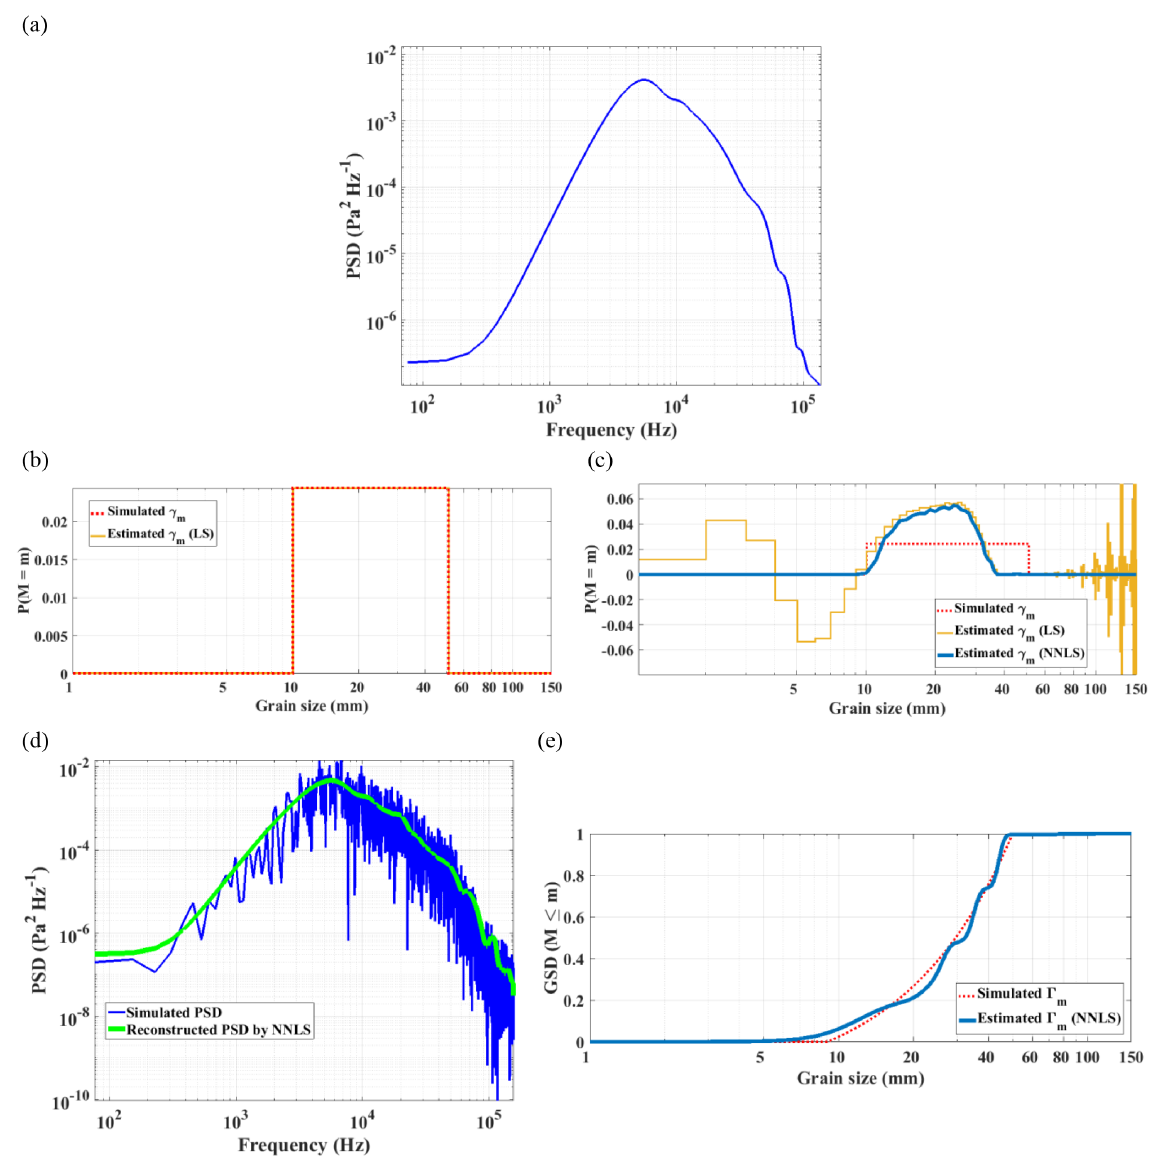
Figure 4. (a) Simulated PSD from the uniform PMF γ m of sediments, 10kg per 1mm size class, from 10 to 50mm, where the impact velocity is U imp = 1ms − 1 ; the other input parameters are defined in Table 1; (b) the PMF solution obtained by the classical LS inversion, Eq. (12). The parameters used to simulate the PSD (grain size and impact velocity) shown in (a) are exactly the same as those used in modeling the dictionary (cid:49) ; (c) the PMF solutions obtained from the inversion of the spectrum shown in (a) using the two algebraic methods: the classical LS and the NNLS algorithm. The impact velocity used in modeling is U imp = 0 . 1ms − 1 , whereas in the simulation it is U imp = 1ms − 1 (the other input parameters remain the same as in the simulation); the solution γ m is post-processed by smoothing with a Gaussian moving window of 5mm; (d) the simulated PSD shown in (a) with added variance (see text for the noise simulation procedure); (e) the cumulative GSD obtained from the inversion of the noised spectrum by the NNNLS algorithm. The estimated solution γ is used to reconstruct the spectrum, shown in green solid line in (d)